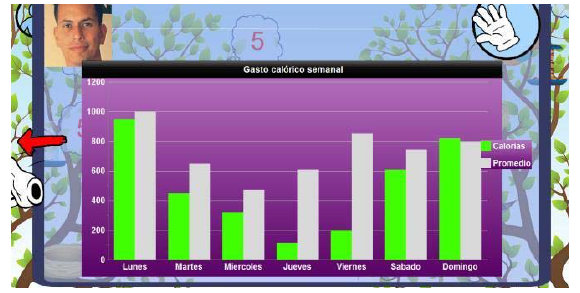
Figure 4 . User data displayed when a user gestures are recognized.